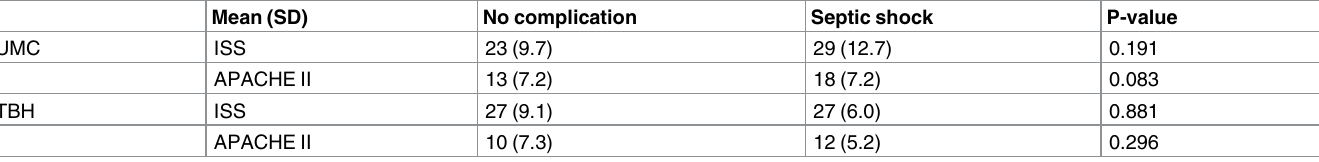
Table 2. Injury severityand complications.